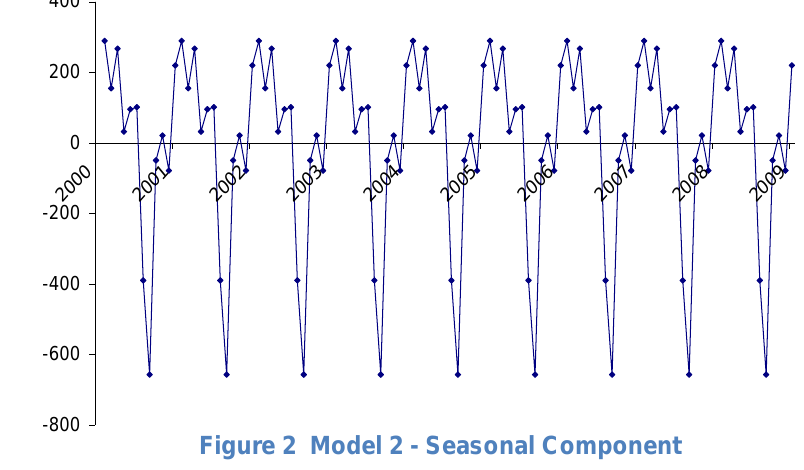
Figure 2 Model 2 - Seasonal